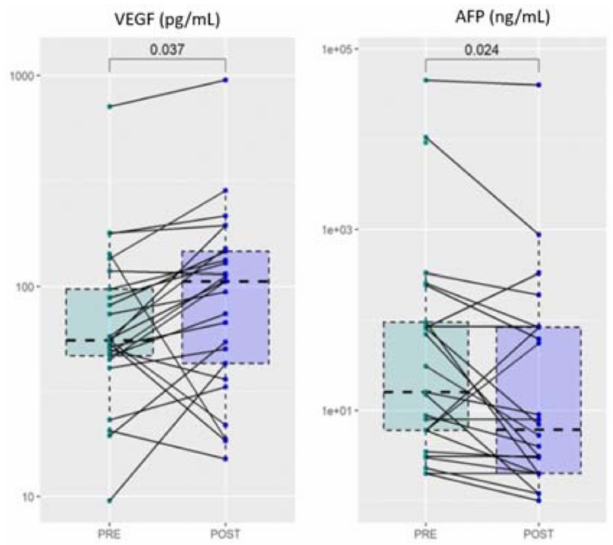
Figure 5. Comparative analysis of VEGF and AFP levels before and after HCC